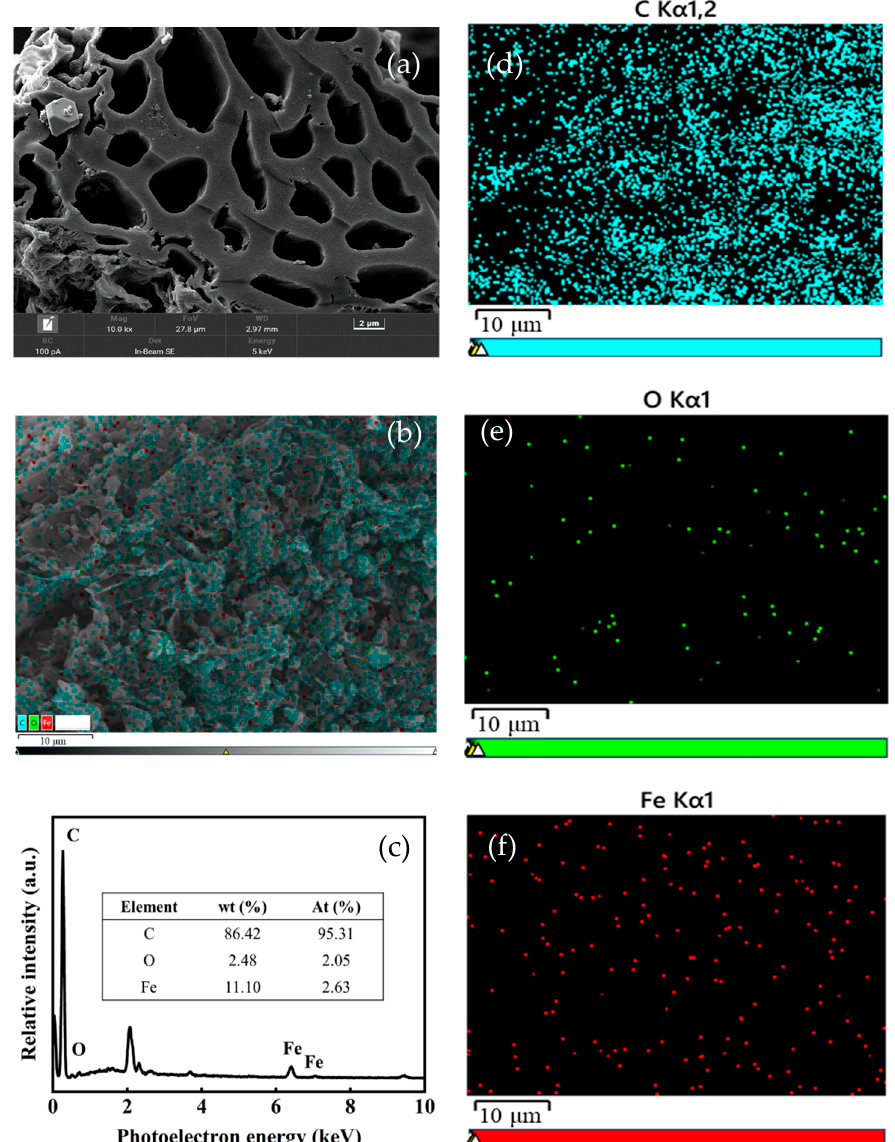
Figure 2. SEM analysis of MAC; ( a ) surface topography; ( b , d – f ) EDS; ( c ) element content.